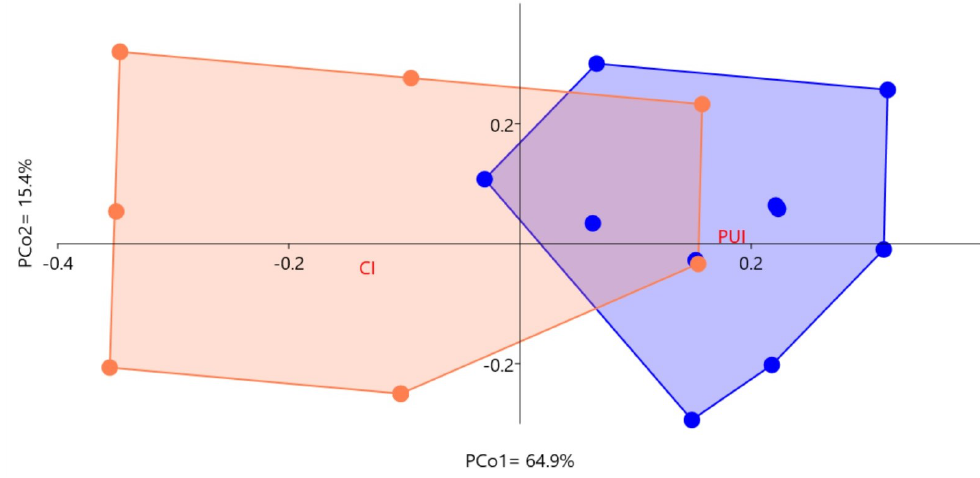
Figure 5. Principal Coordinate Analysis (PCoA) of the raw data. Visualization of the dissimilarities of the ordinal raw